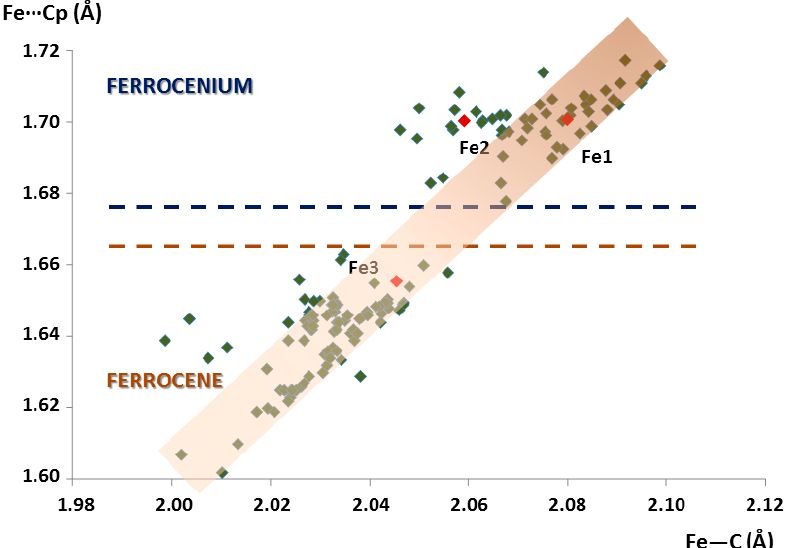
Figure 3. Plot of the average Fe ··· Cg(Cp) distances vs. Fe–C bond lengths for all the ferrocenyl moieties included in the search within the CSD database. Crystallographically independent ferrocenyl units in 1 are indicated in red.